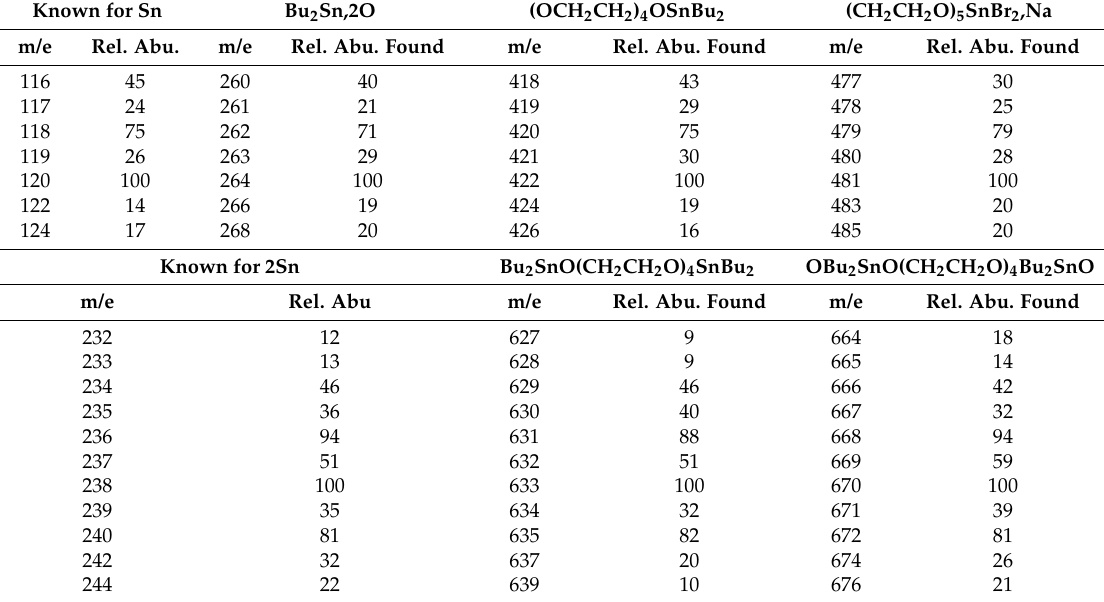
Table 2. Isotopic abundance matches for two ion fragment clusters containing a single tin atom, top part, and two ion fragment clusters with two tin atoms, bottom part. Bu represents a butyl moiety. Known for Sn Bu 2 Sn,2O